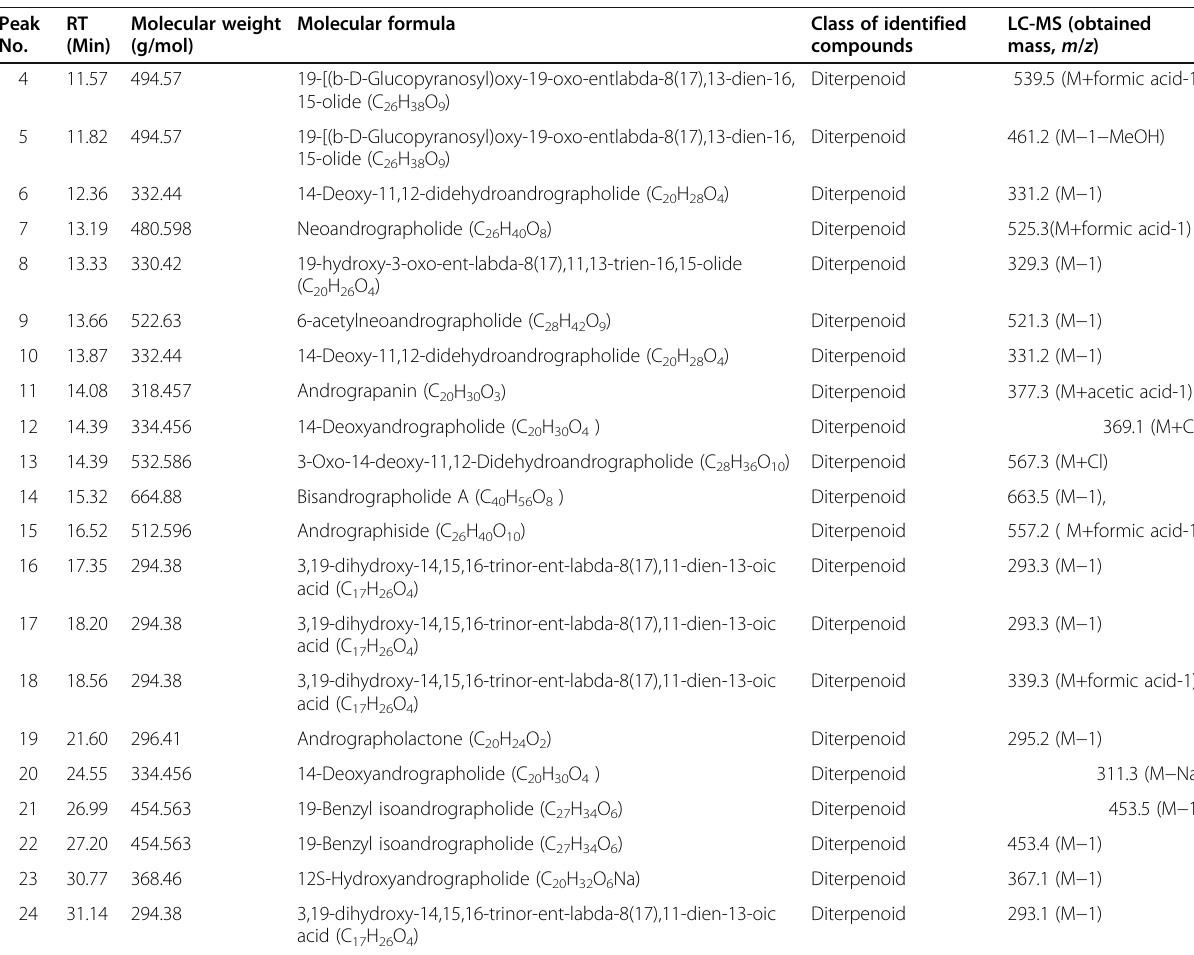
Table 3 Identification of compounds present in anti-malarial active extract of Andrographis paniculata by LC-MS/MS analysis (Continued) Peak RT Molecular weight No. (Min)